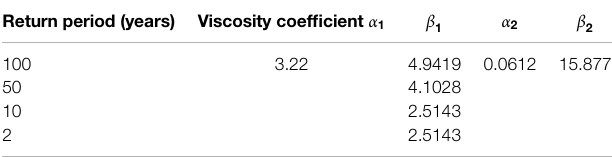
TABLE 3 | Empirical coef fi cients used in the FLO-2D debris fl ow